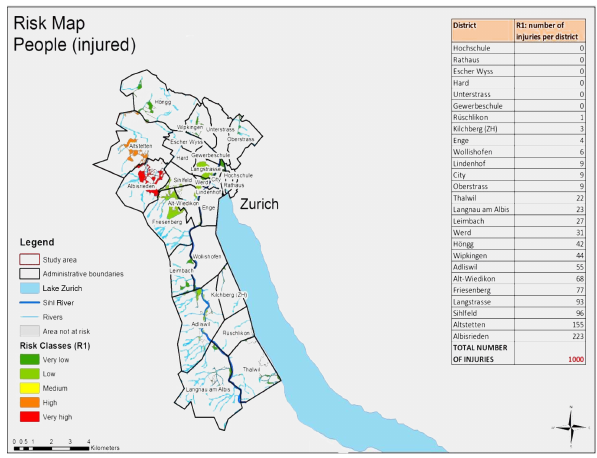
Figure 4. Relative risk map for injured people with statistics at the district level.